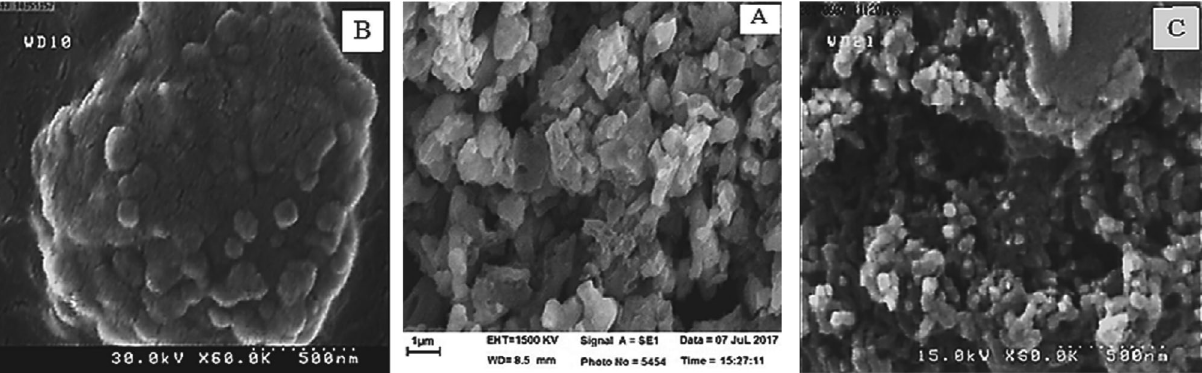
Fig. 1: SEM images (A) CFNC before adsorption of metal ions on a scale of 500 nm, (B) adsorbent after adsorption of chromium(III) ions on a scale of 1 µm, (C) adsorbent after adsorption of Cadmium(II) ions on a scale of 500